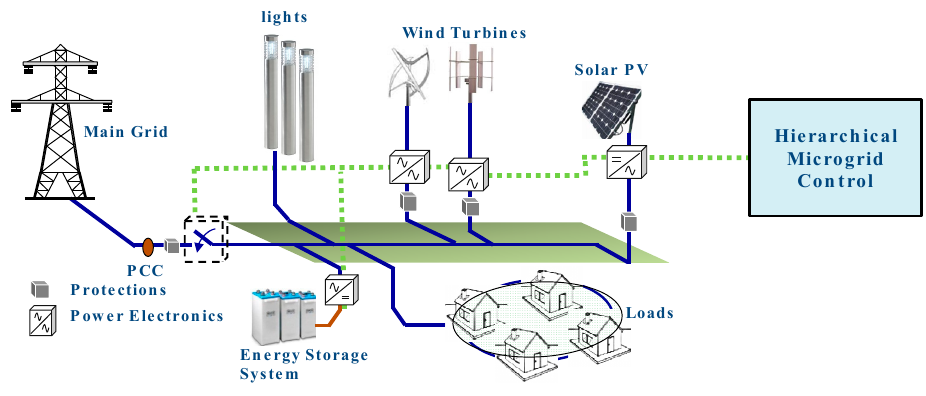
Figure 1. Microgrid general scheme.